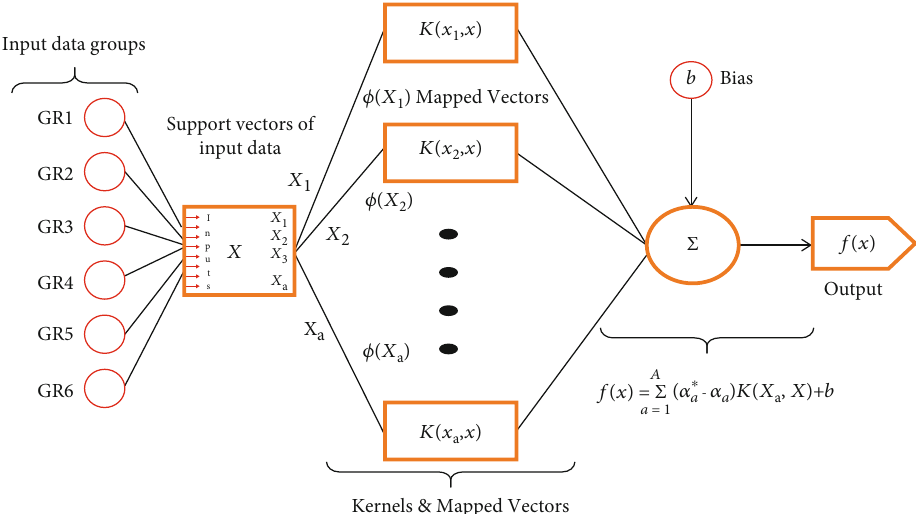
Figure 6: SVR ’ s architectural